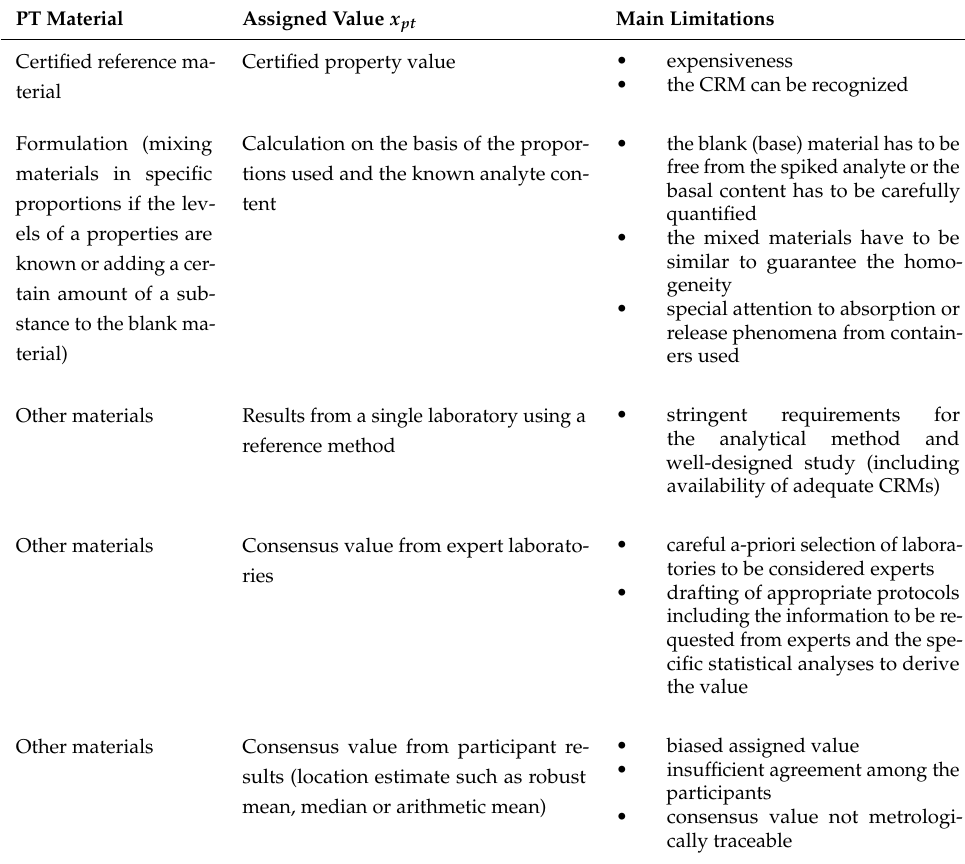
Table 3. Approaches to set the assigned value and their main